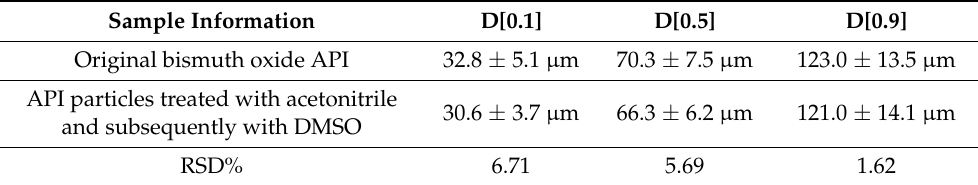
Table 3. PSD values of bismuth oxide API before and after being processed according to sample treatment.